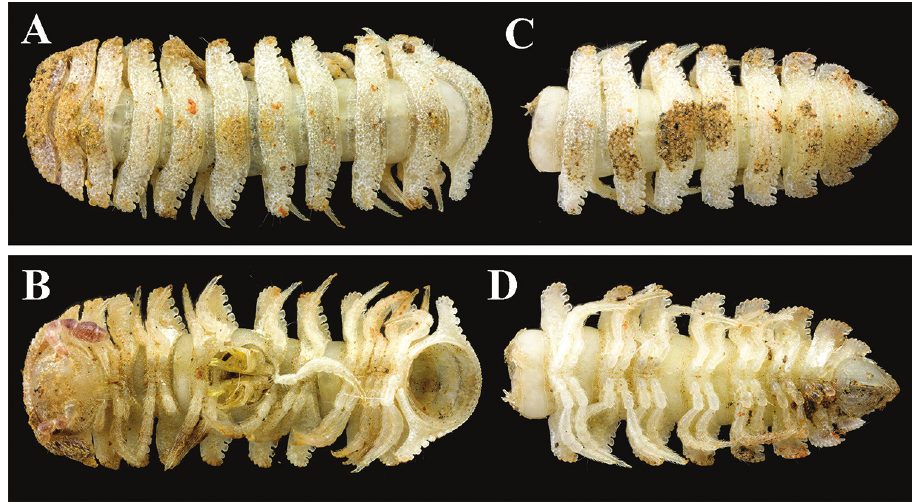
Figure 4. Trichopeltis intricatus sp. n., ♂ holotype. A–B anterior part of body C–D posterior part of body, dorsal and ventral views,